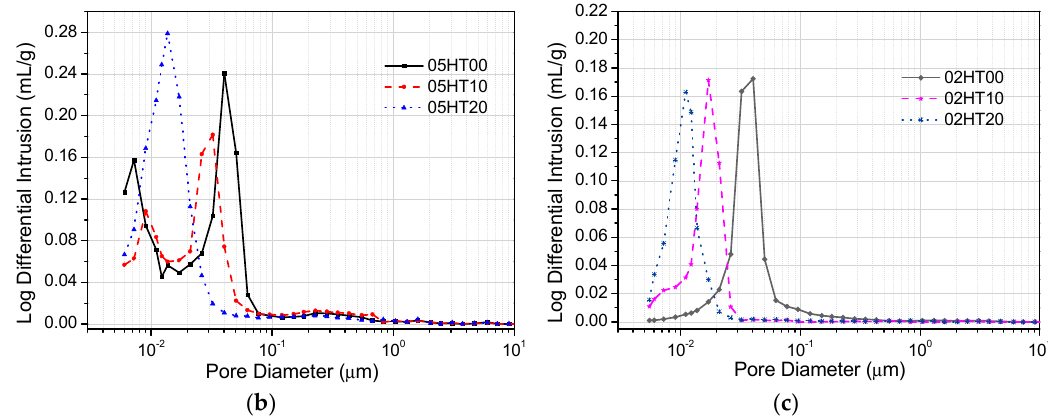
Figure 14. ( a ) Cumulative intrusion volume after 28 days. ( b ) Differential intruded volume when w/b = 0.5. ( c ) Differential intruded volume when w/b = 0.2.